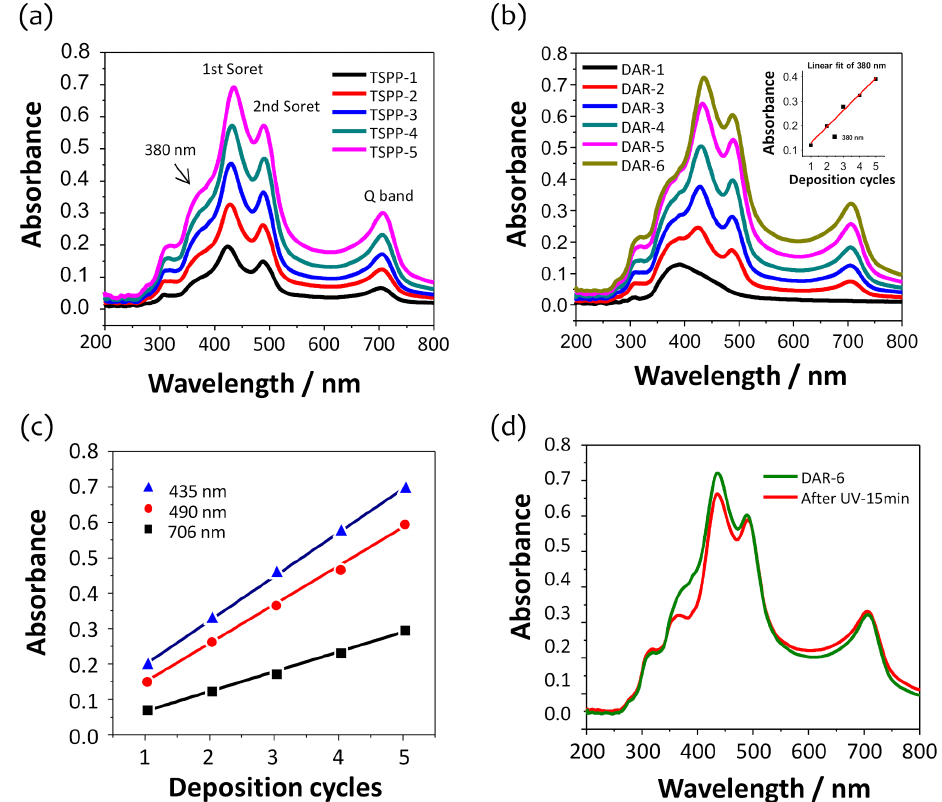
Figure 2. Evolution of the UV-vis absorption spectra of the DAR/TSPP+PSS (0.025 wt%) alternate layers deposited onto the 1-cm-long stripped core of a U-bent optical fiber when the outermost layer was deposited with ( a ) TSPP+PSS and ( b ) DAR, respectively. ( c ) Absorbance changes measured at ( (cid:78) ) 435, ( • ) 490, and ( (cid:4) ) 706 nm. ( d ) Comparison of the UV-vis absorption spectra of the 5-cycle DAR/TSPP+PSS (0.025 wt%) film with an outermost layer of DAR before and after exposure to UV irradiation for 15